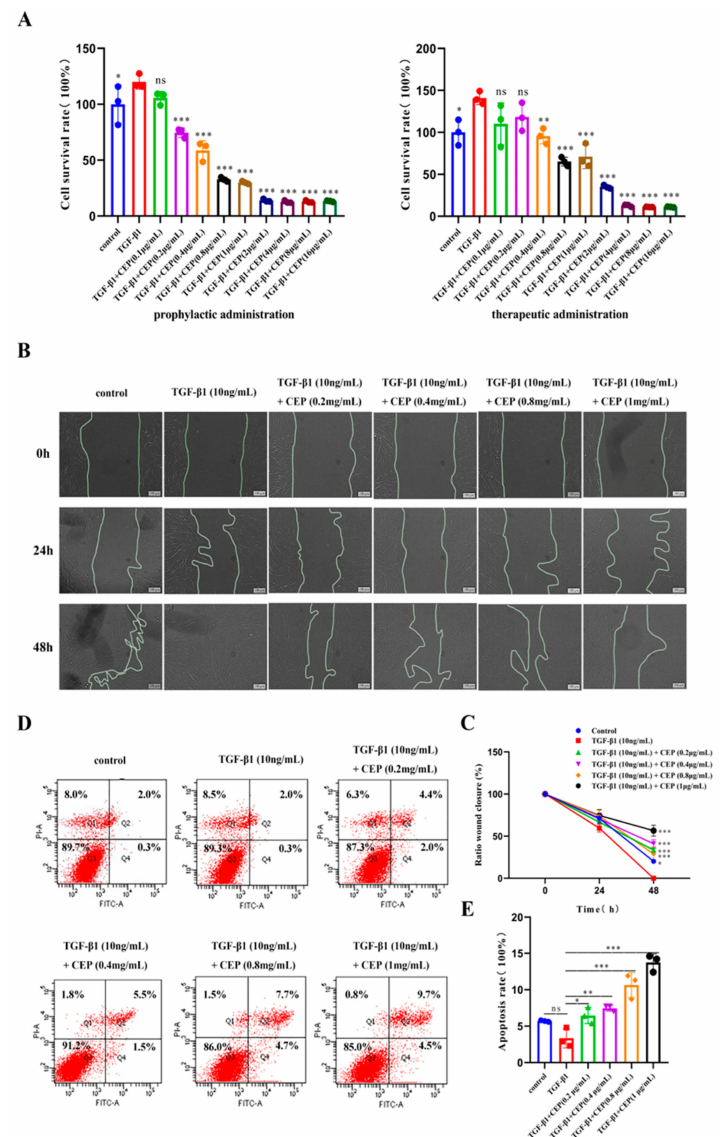
Figure 2. Effects of CEP on TGF- β 1-induced apoptosis, viability, and migration of